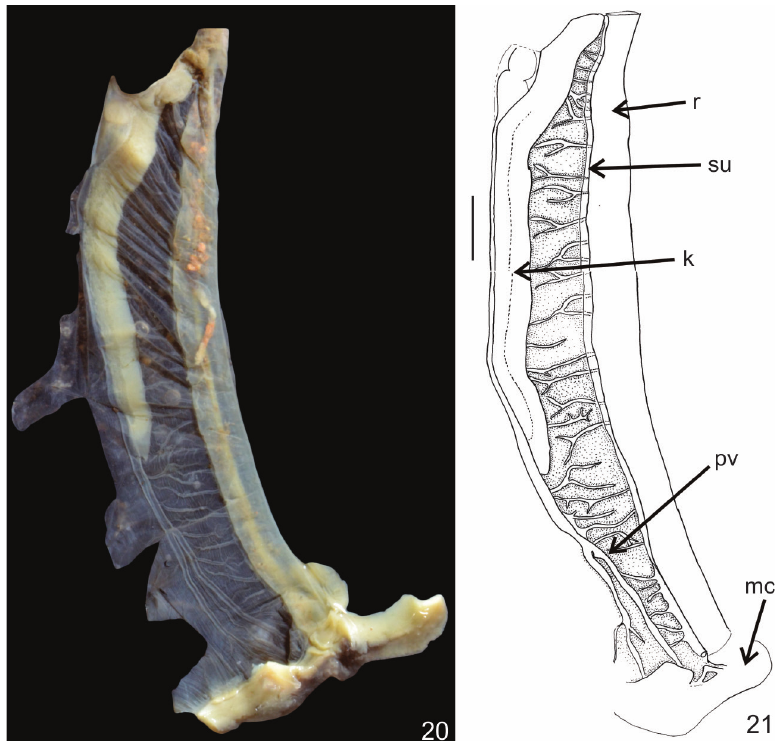
Figures 20–21. Pallial system: (20) photograph of the ventral zone of the pulmonary roof, note the long kidney, with respect to the total length of the lung; (21) line drawing of the same region detailing the limits between kidney and ureter and the shallow veins crossing the pulmonary roof. Scale bar: 21 = 5mm. Abbreviations (k) kidney, (mc) mantle collar, (pv) pericardic vein, (r) rectum, (su) secondary